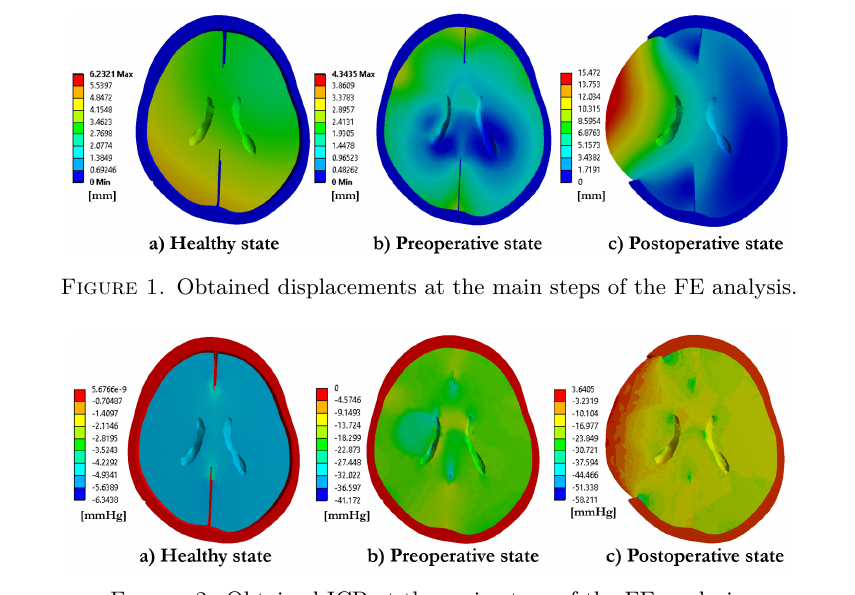
Figure 2. Obtained ICP at the main steps of the FE